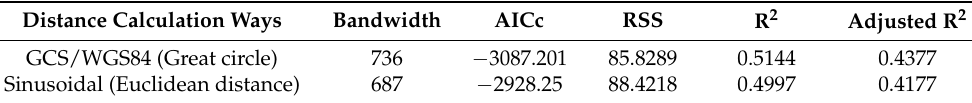
Table 3. A comparison of model-fitting performances for GWR based on different distance calculation